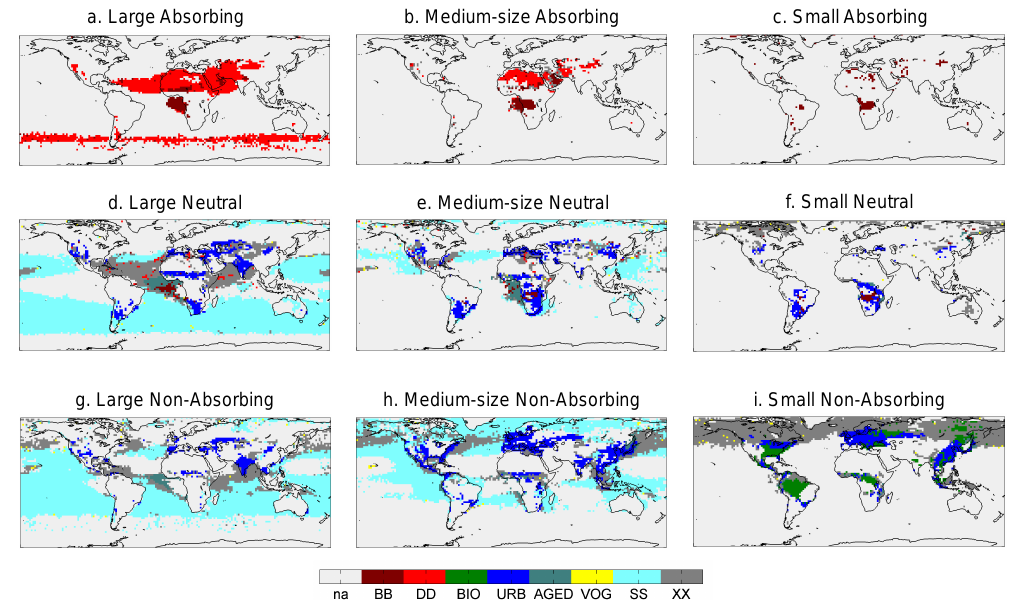
Figure 7. Global aerosol source for each aerosol type according to GACA for June–August 2007–2011. Aerosol source and type abbrevia- tions are given in Table 2; gray areas do not contain more than four points belonging to the relevant aerosol